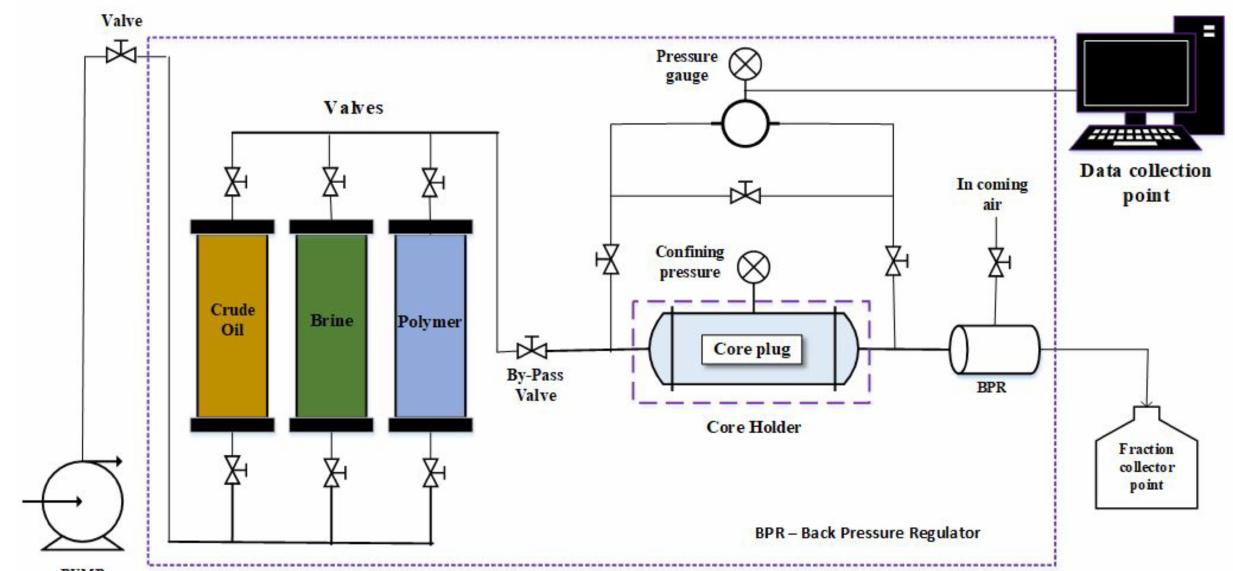
Figure 2. Core flood experimental